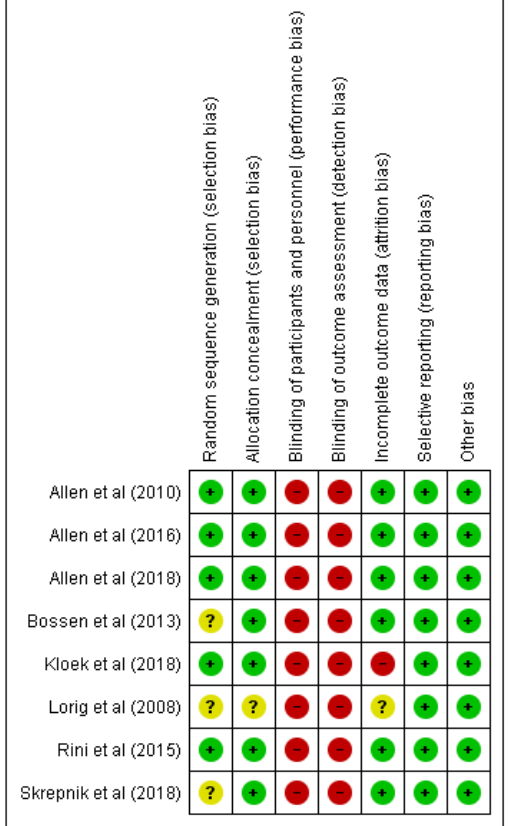
Figure 2. Summary of risk of bias